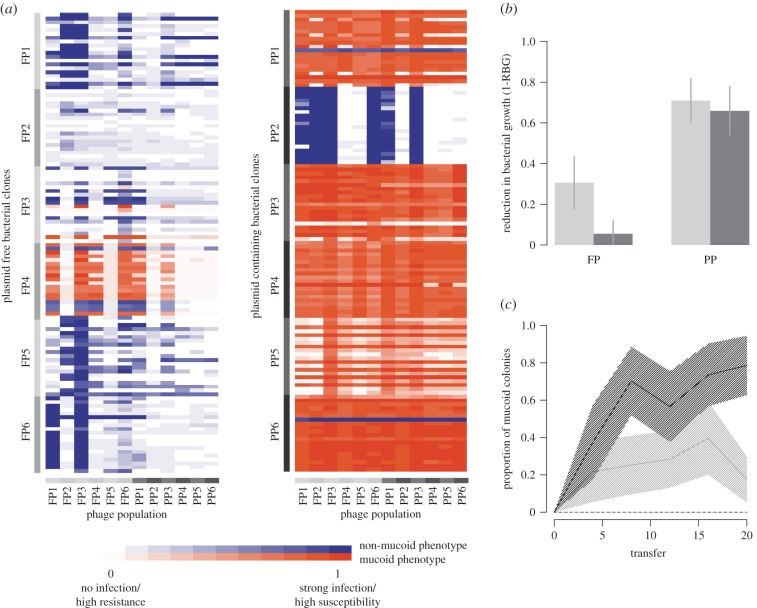
Bacterial responses to phage infection. (a) Infection heat maps of pairwise interactions between the 120 bacterial clones (20 per population, six populations per treatment) from the plasmid-free (FP1-FP6; left) and plasmid-containing (PP1-PP6; right) populations with phage populations from both treatments (n = 12). Bacterial clones are grouped by population along the y-axis and phage populations grouped by treatment along the x-axis, indicated by grey tabs. Colours denote the mucoid status of each clone with intensity scaled by 1-RBG value (where darker indicates high 1-RBG and therefore phage infection). (b) Mean reduction in bacterial growth owing to phage predation (1-RBG) for bacterial clones from the plasmid-free (FP) and plasmid-containing (PP) treatments challenged against phages isolated from the plasmid-free (light) and plasmid-containing (dark) treatments. Lines show standard error of population means (n = 6). (c) Mean frequency of mucoidy over time. Lines show means (n = 6) for the four treatments; plasmid-containing treatments are shown in black and plasmid-free in grey. Phage-containing treatments are shown as fixed lines and phage-free control lines shown as dashed. Shading indicates standard error.